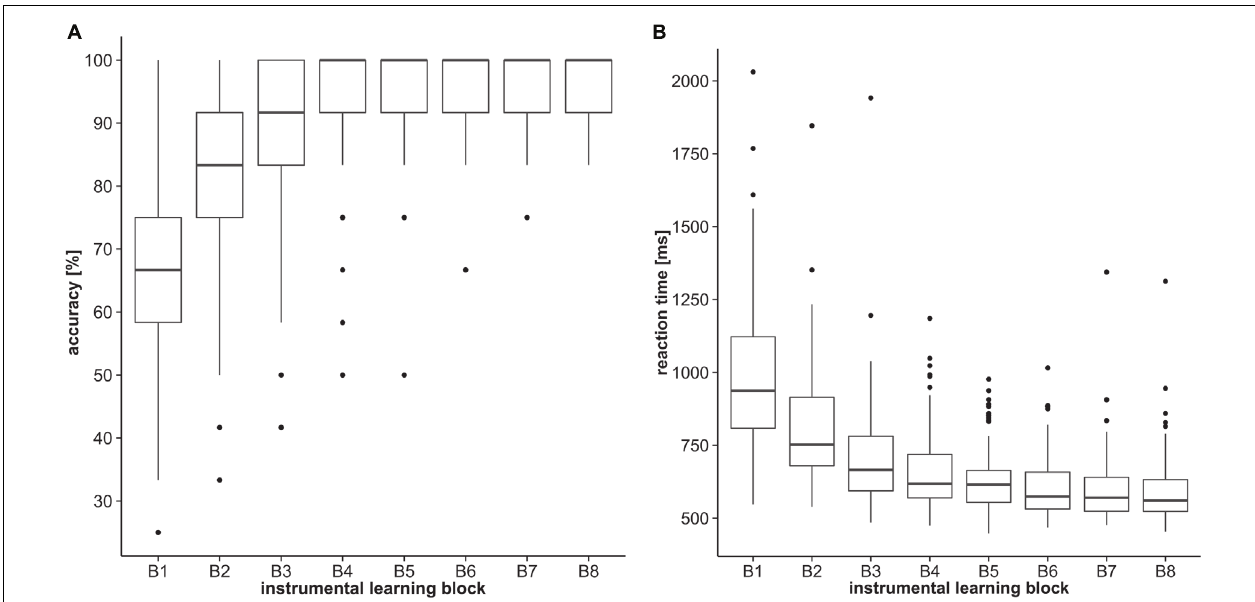
FIGURE 2 | Discrimination training performance. Boxplots represent (A) accuracy (percentages of correct responses) and (B) reaction times of the eight discrimination training